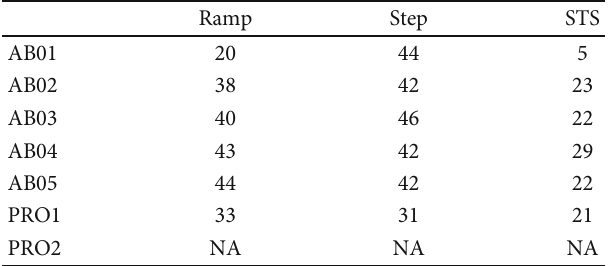
Figure 5: Data collection setup for the sit-to-stand and stand-to-sit trials. Table 4: The number of available trials (repetitions) is listed for each activity except walking. STS indicates stand-to-sit or sit-to- stand. See Tables 5 and 6 for the number of walking